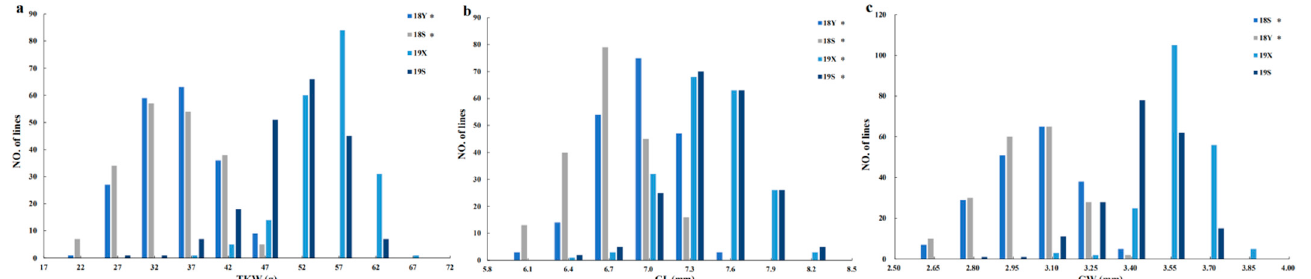
Figure 1. ( a ) Frequency distributions for thousand kernel weight (TKW), ( b ) grain length (GL) and ( c ) grain width (GW), respectively, of 194 F 6 recombinant inbred lines (RILs) derived from the cross of HN5290×06Dn23 and their parents over four environments (18S, 18Y, 19X and 19S). The 18S and 19S, Shijiazhuang, China 2017–2018 and 2018–2019; 18Y, GaoYi,